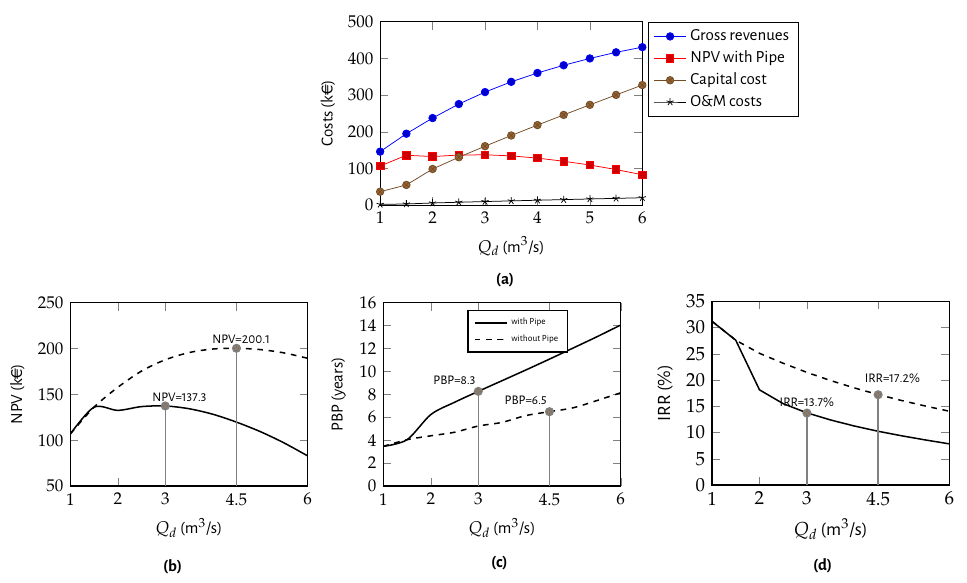
Figure 6. AST economic analysis results as a function of the design discharge with and without the pipe cost: ( a ) CC, O&M costs, revenues and NPV; ( b ) NPV; ( c ) PBP; ( d ) IRR.